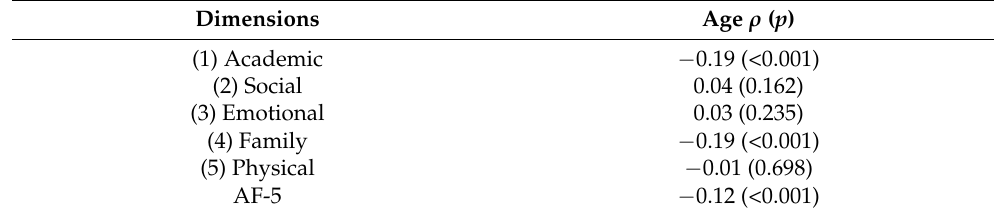
Table 3. Correlations between the dimensions and the age group